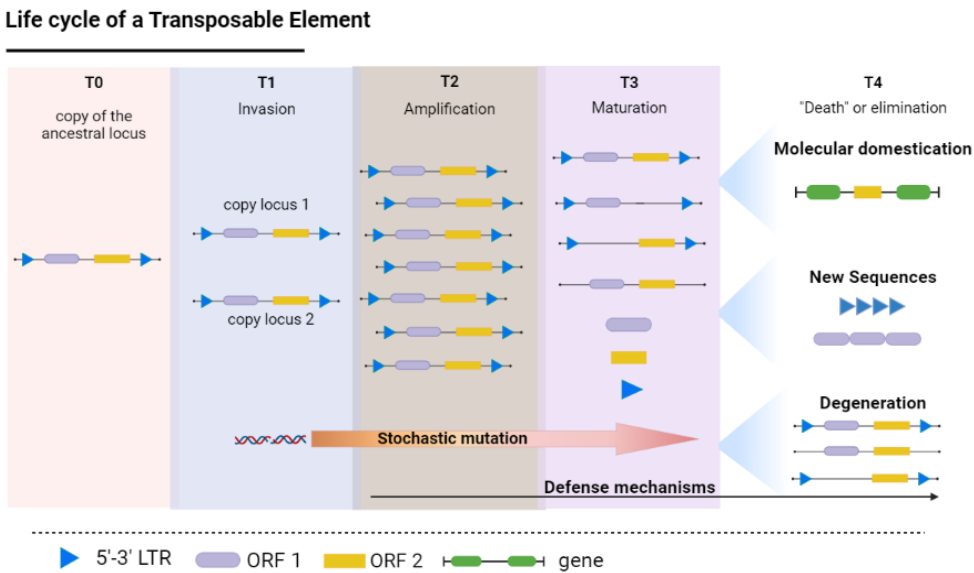
Figure 1. Life cycle of a transposable element, using LTR transposons with their respective Open Reading Frames (ORFs) as an example. T0— simple copy of the element in the genome; T1—Invasion: the chromosomal locus acquires at least one repeat unit; T2—Amplification: an increase in the number of copies present in the genome, either by burst events (in the case of class I elements) or the repair or homologous recombination of double-stranded DNA (class II); T3—Maturation : the elements are inactivated or silenced through epigenetic silencing, piRNAs, DNA methylation or other mechanisms, such as mutations; T4—Death or degeneration : the elements may be either eliminated from the genome, undergo molecular domestication, begin to exercise new functions or give rise to new repetitive sequences, such as tandem repeats. LTR = Long Terminal Repeat; ORF = Open Reading Frame. (Source: the authors / created in Biorender.com, accessed on 05/09/2022).